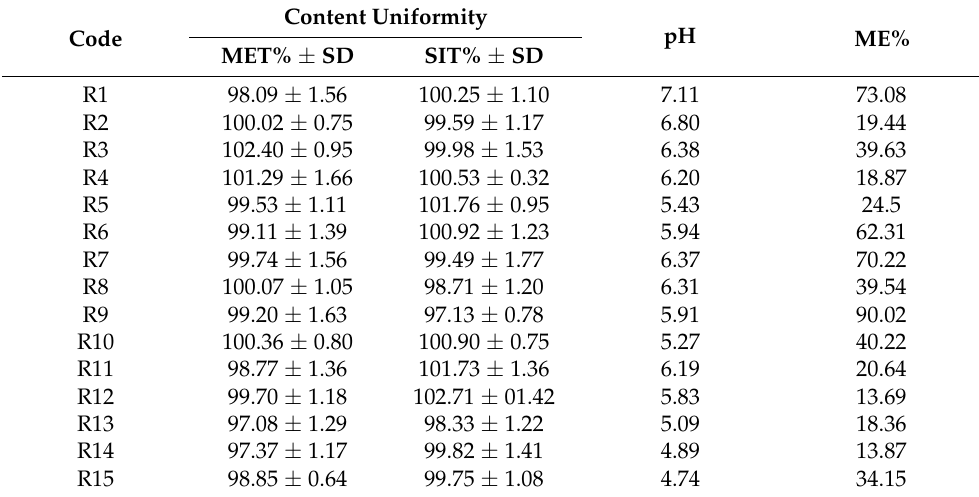
Table 2. Physicochemical characterization of the buccal